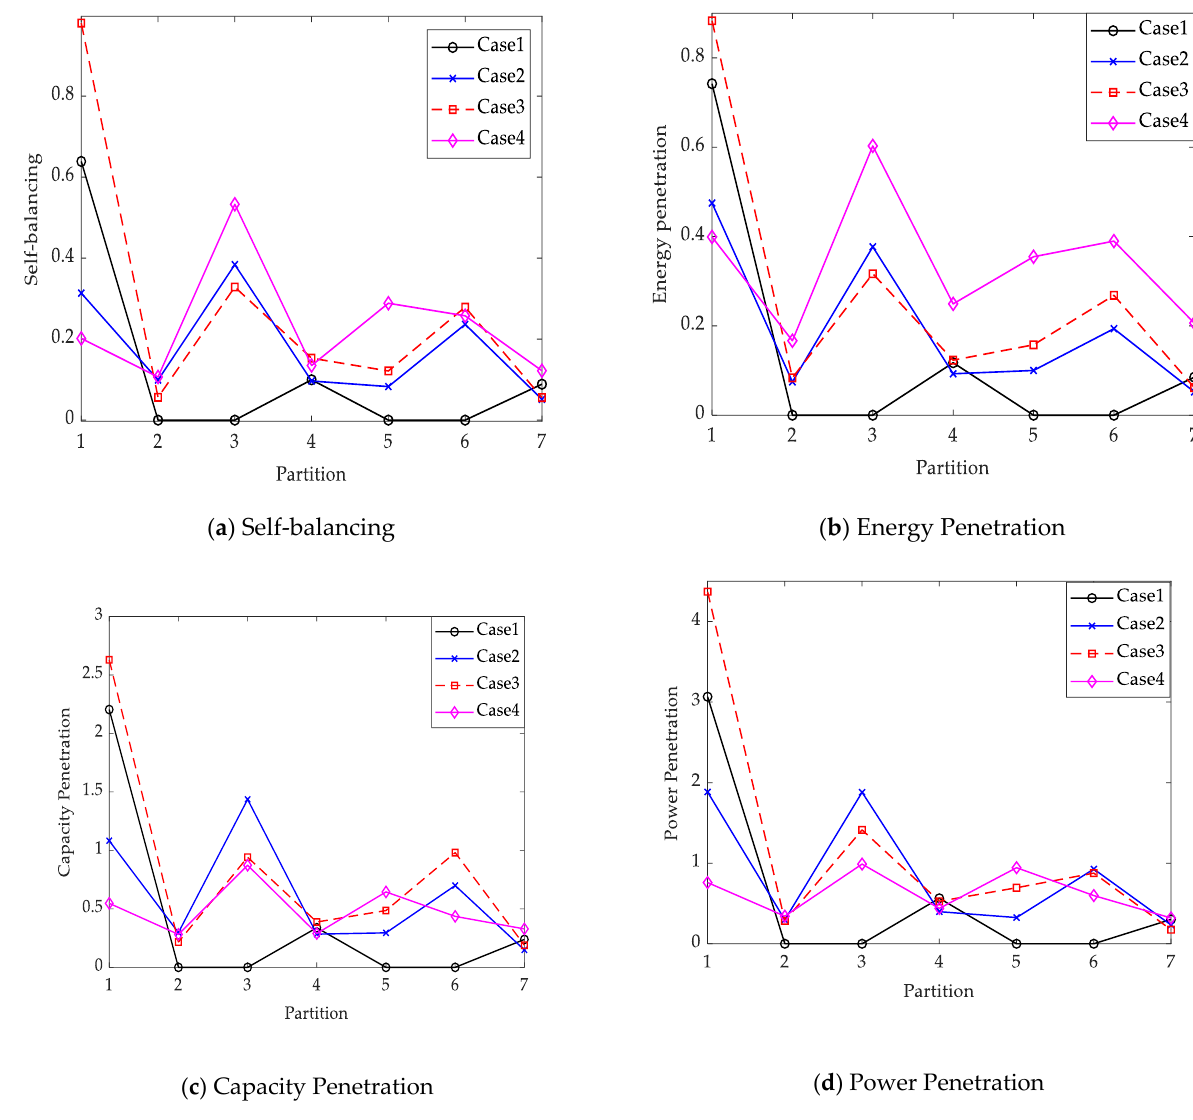
Figure 12. Evaluation indicators for each program.